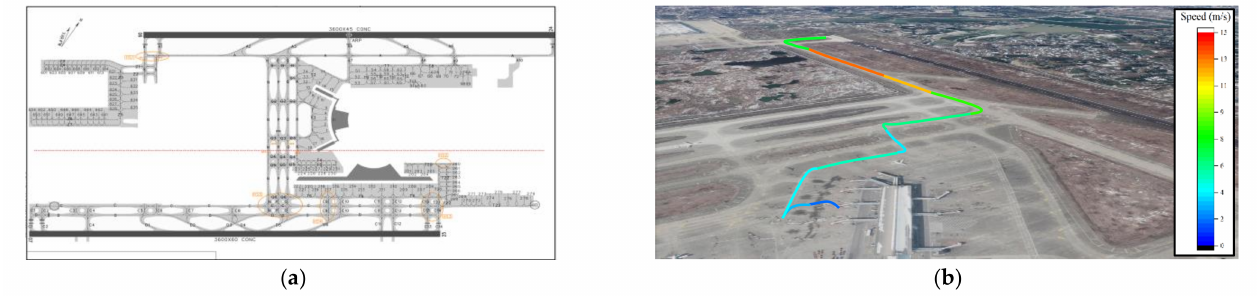
Figure 5. Basic data of ZSNJ used for MPSTRs generation. ( a ) Physical structure; ( b ) historical taxiing path and speed profile.